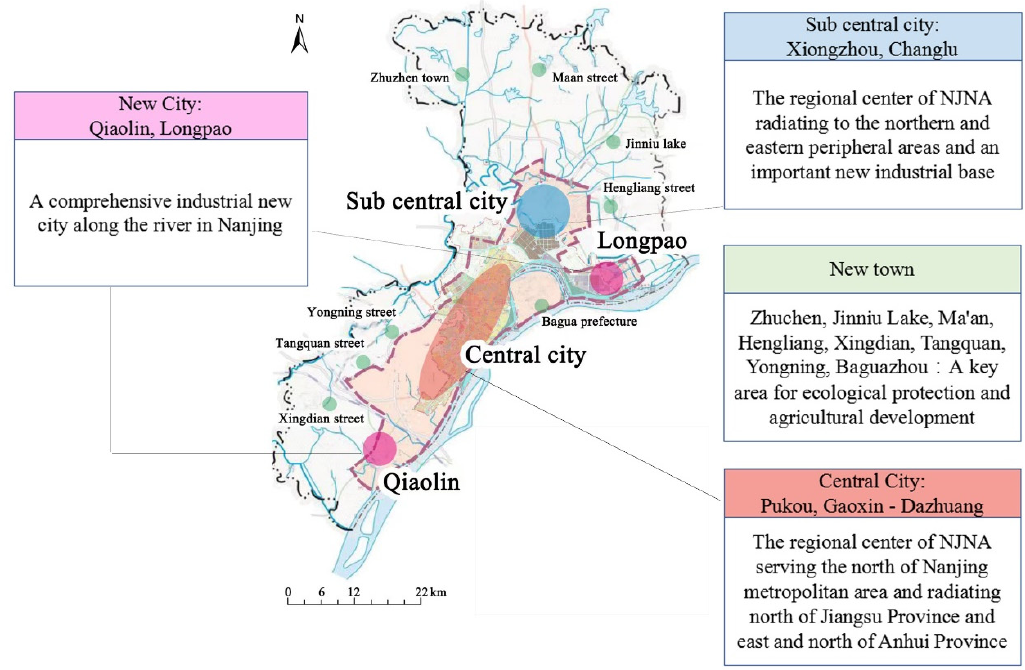
Figure 4. Guidance for the spatial optimization of planning for NJNA.